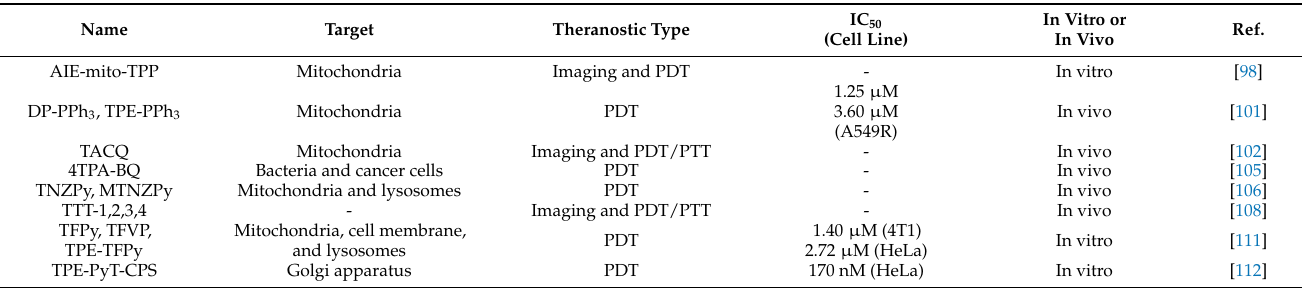
Figure 7. Schematic illustration of AIEgen inducing Golgi stress and the crosstalk between Golgi and mitochondria for cell apoptosis upon PDT. Adapted with permission from [112]. Copyright 2022 Springer Nature. Table 3. AIEgen-based assembly for theranostic